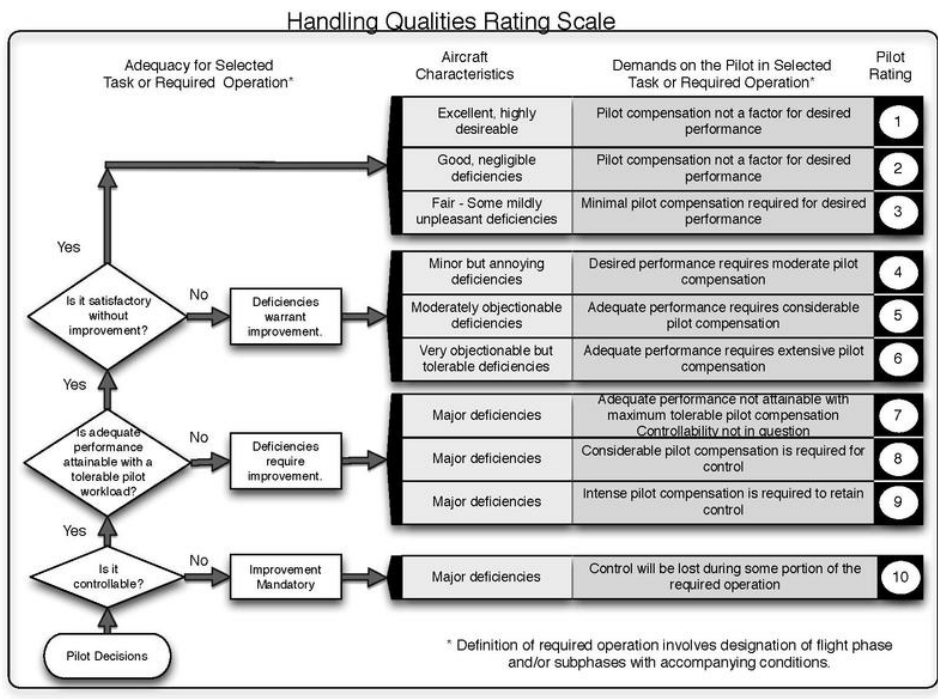
Figure A2. Cooper-Harper [69] handling qualities rating scale.